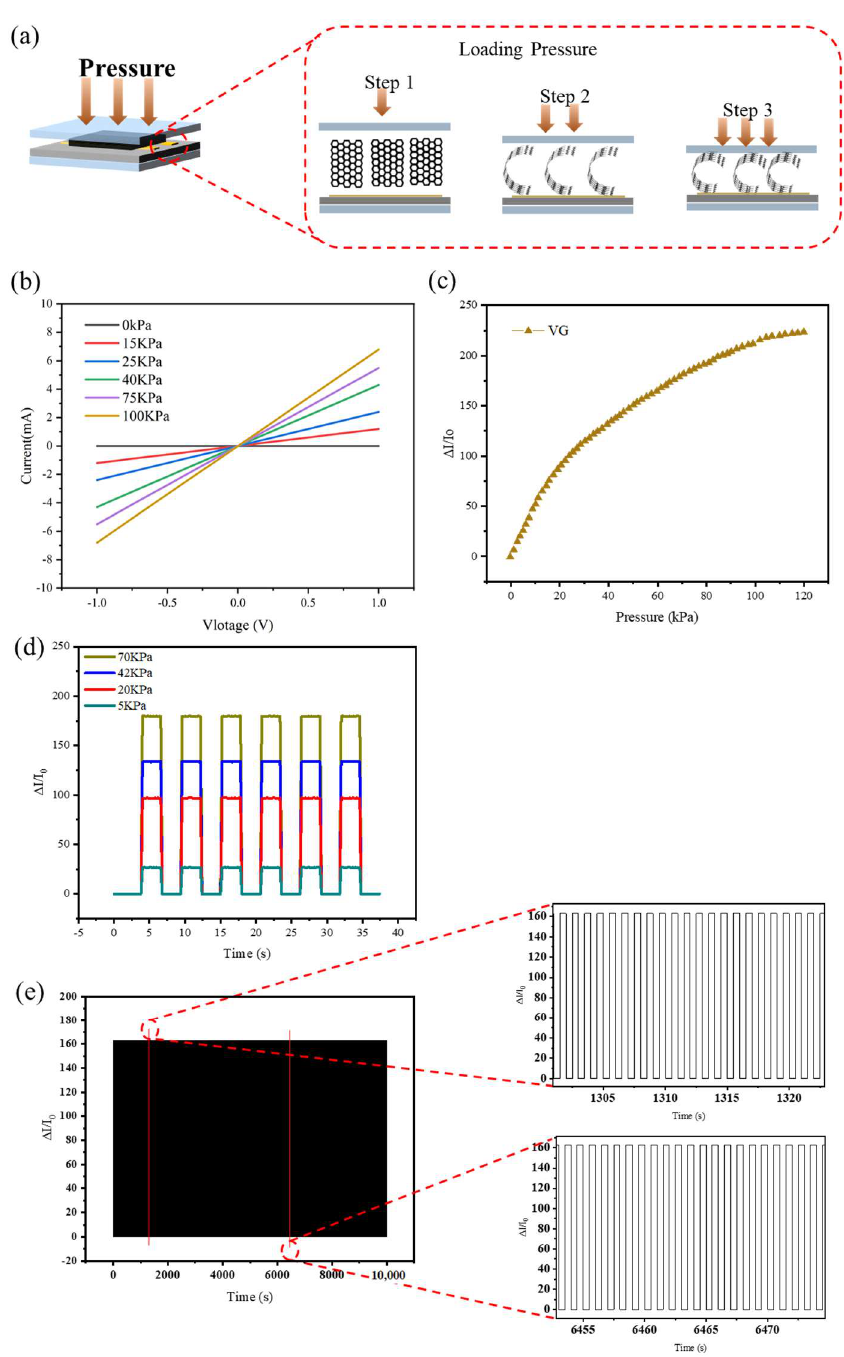
Figure 3. Sensing performances of the flexible VG sensor: ( a ) schematic diagram of the working mechanism of a flexible pressure sensor; ( b ) I−V curves of the sensor with applied pressure including 0 KPa, 15 KPa, 25 KPa, 75 KPa, and 100 KPa; ( c ) current response (∆ I/I 0 ) vs. applied pressure; ( d ) current changes in sensors at different pressures (5, 20, 42, 70 KPa); ( e ) cycling test under external pressure of 60 KPa for 5000 cycles.